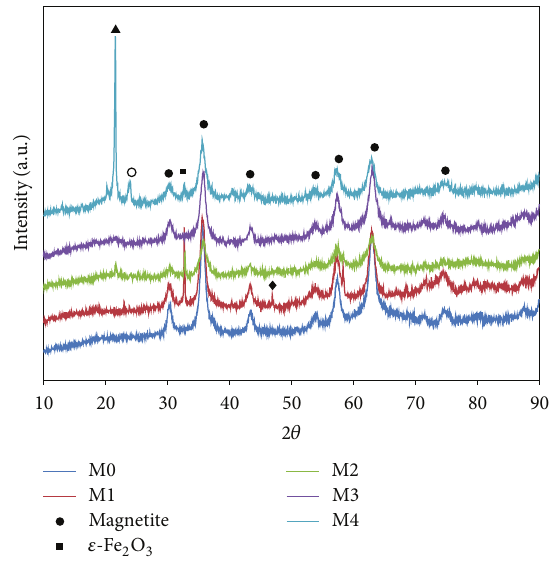
Figure 1: The XRD pattern of the synthesize Fe 3 O 4 particles with various amounts of surfactant.